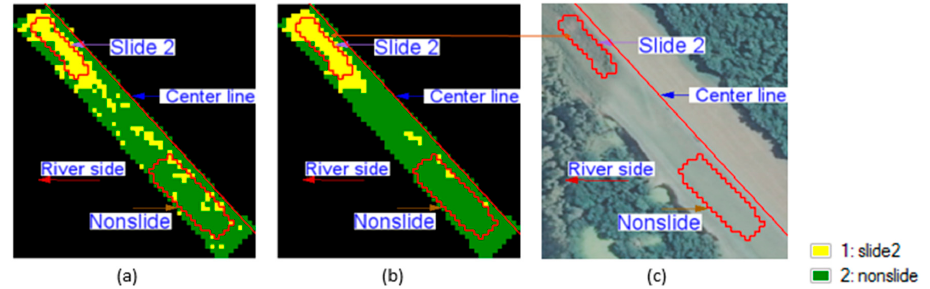
Figure 7. Complex data classification for the segment Sample 2: ( a ) without majority filter; ( b ) with majority filter; ( c ) optical image overlaid with slide and nonslide class shapes.